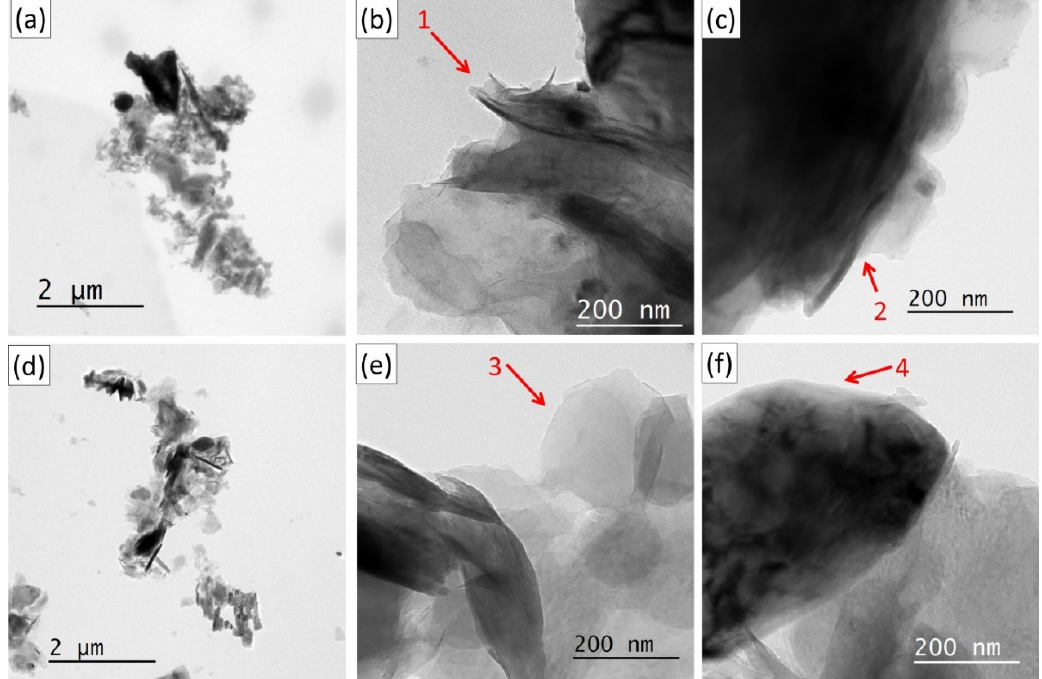
Figure 7. Low magnification TEM images of ( a – c ) biwettable and ( d – f ) hydrophilic coarse clay aggregates. The specimens were prepared using a freeze-dry method (see